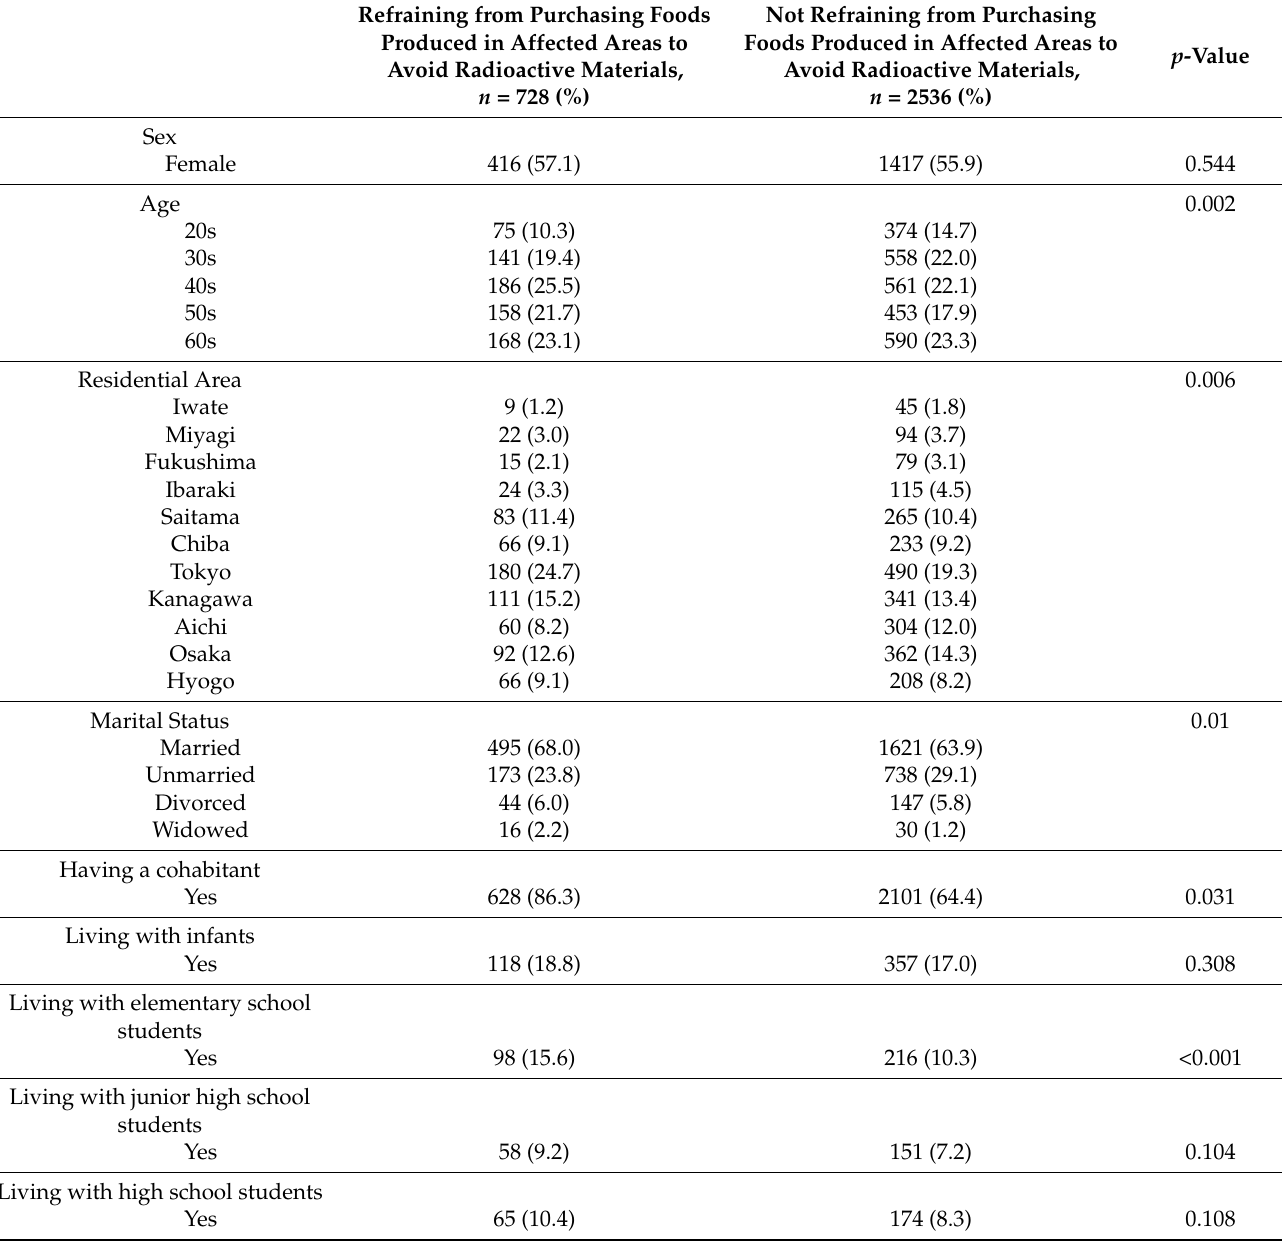
Table 3. Comparison between refraining from purchasing foods produced in affected areas to avoid radioactive materials or not in the 14th